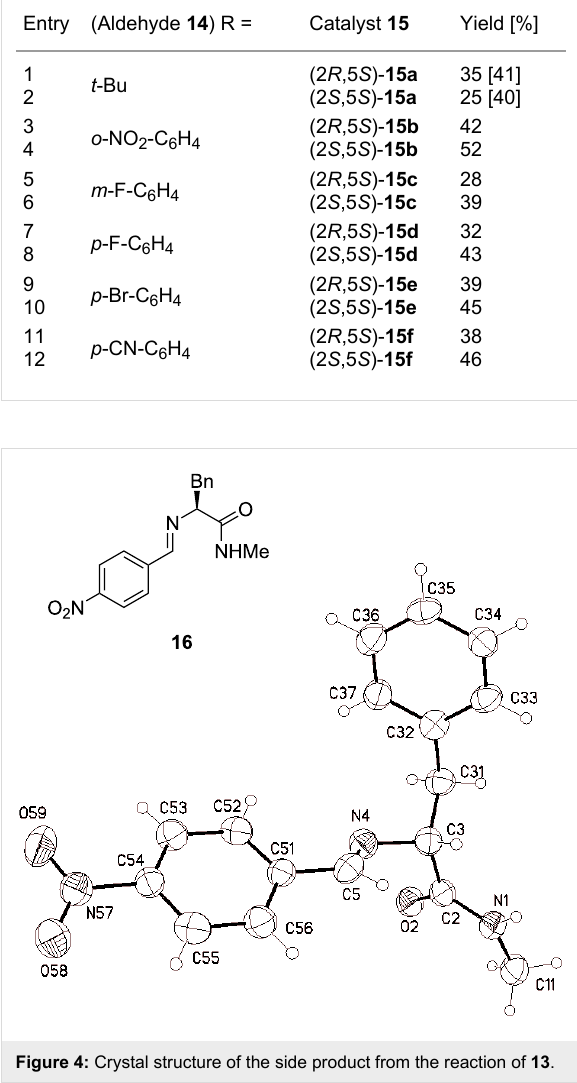
Table 3: Results of the conversion of various aldehydes 14 with amide 13 . Entry (Aldehyde 14 ) R =